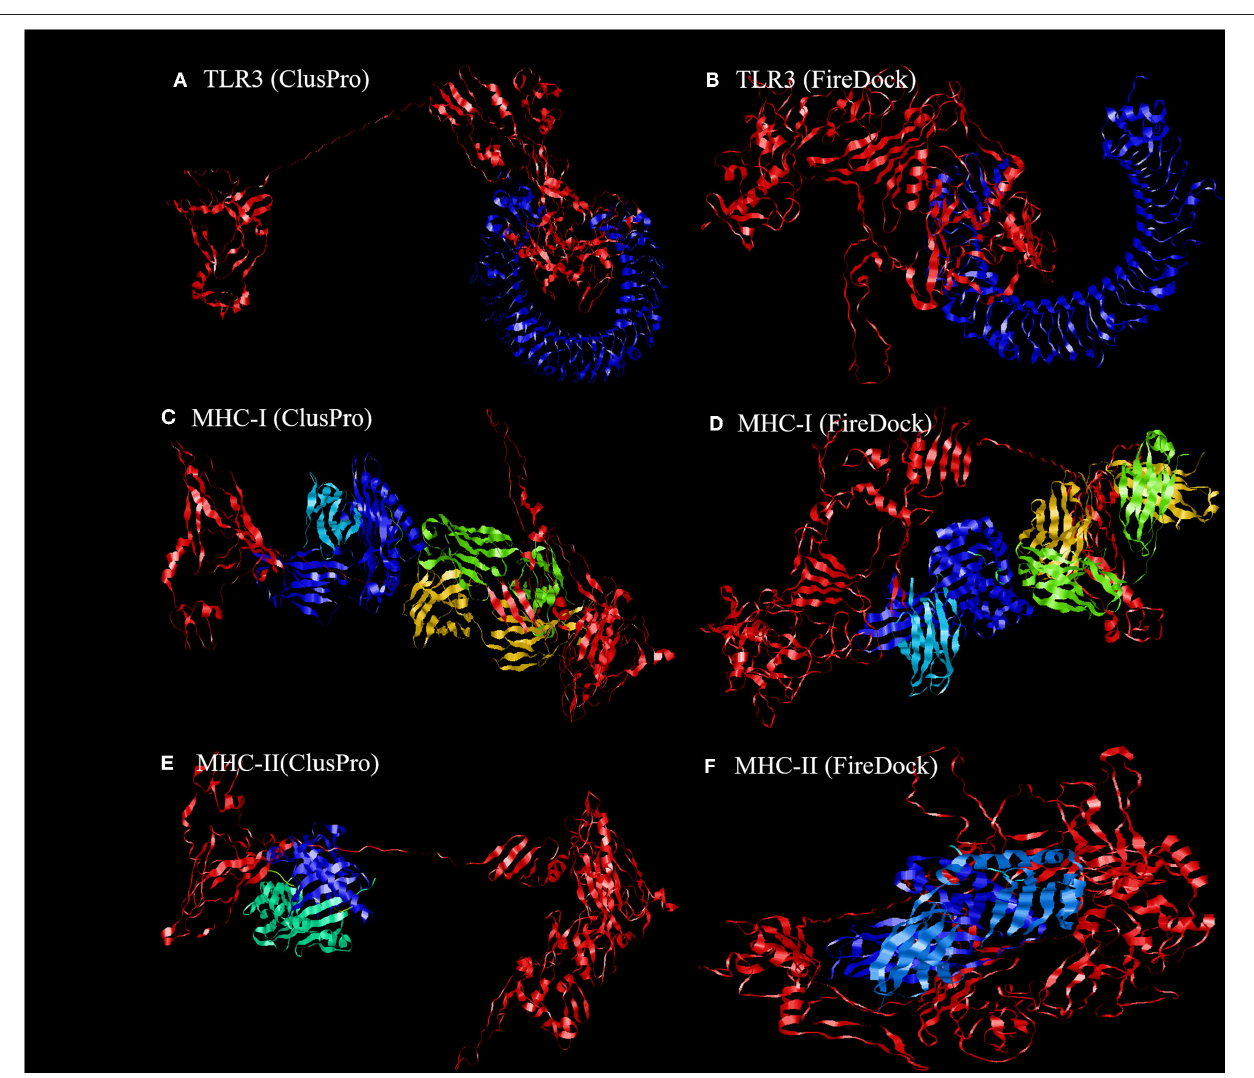
FIGURE 6 | Representation of the ligand-receptor docked complex. (A,C,E) show the molecular docking of the vaccine construct (red color) and TLR-3, MHC-I, and MHC-II receptors (other colors) illustrated using the ClusPro software. (B,D,F) show the molecular docking of the vaccine construct (red color) and TLR-3, MHC-I, and MHC-II receptors (other colors) illustrated using PatchDock to verify the stability of the docked complex.